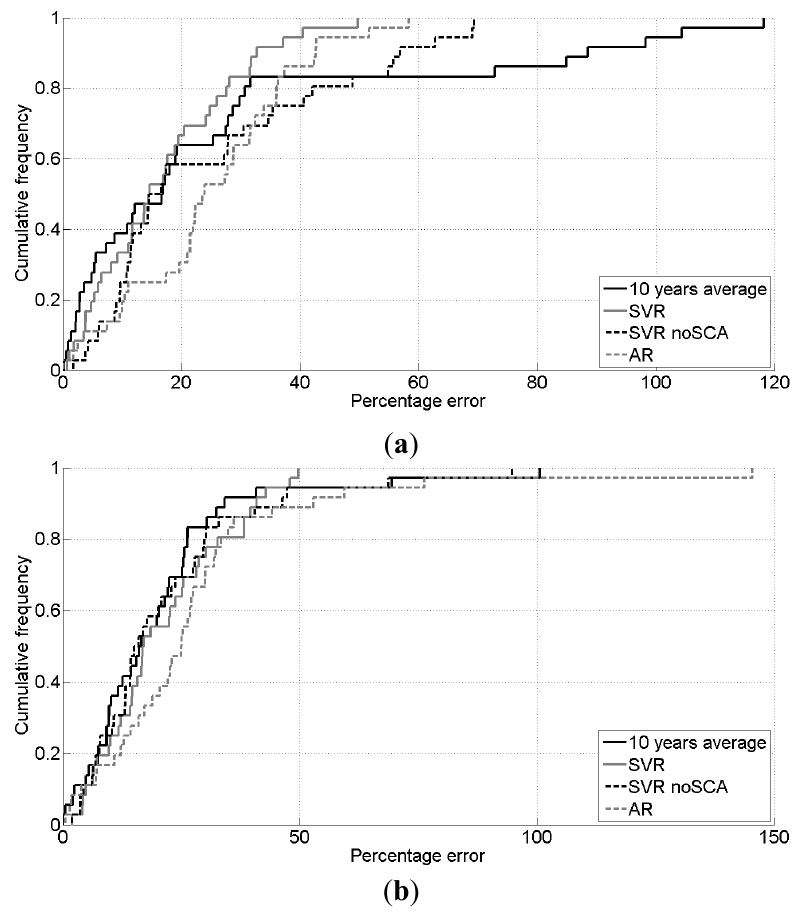
Figure 8. Cumulative frequency of the percentage error computed on the test set for watershed n. 7 (Adige at Ponte Adige), chosen as illustrative example. Each pdf shows the percentage error distribution for different input features configuration. The full gray line represents the selected SVR configuration. The benefit of the SVR approach with respect to the methods based on the 10-year average discharge (full black line) and to the AR method (dashed gray line) is clear as well as the improvement given by SCA (dashed black line). ( a , b ) show a prediction lag equal to one and three months,